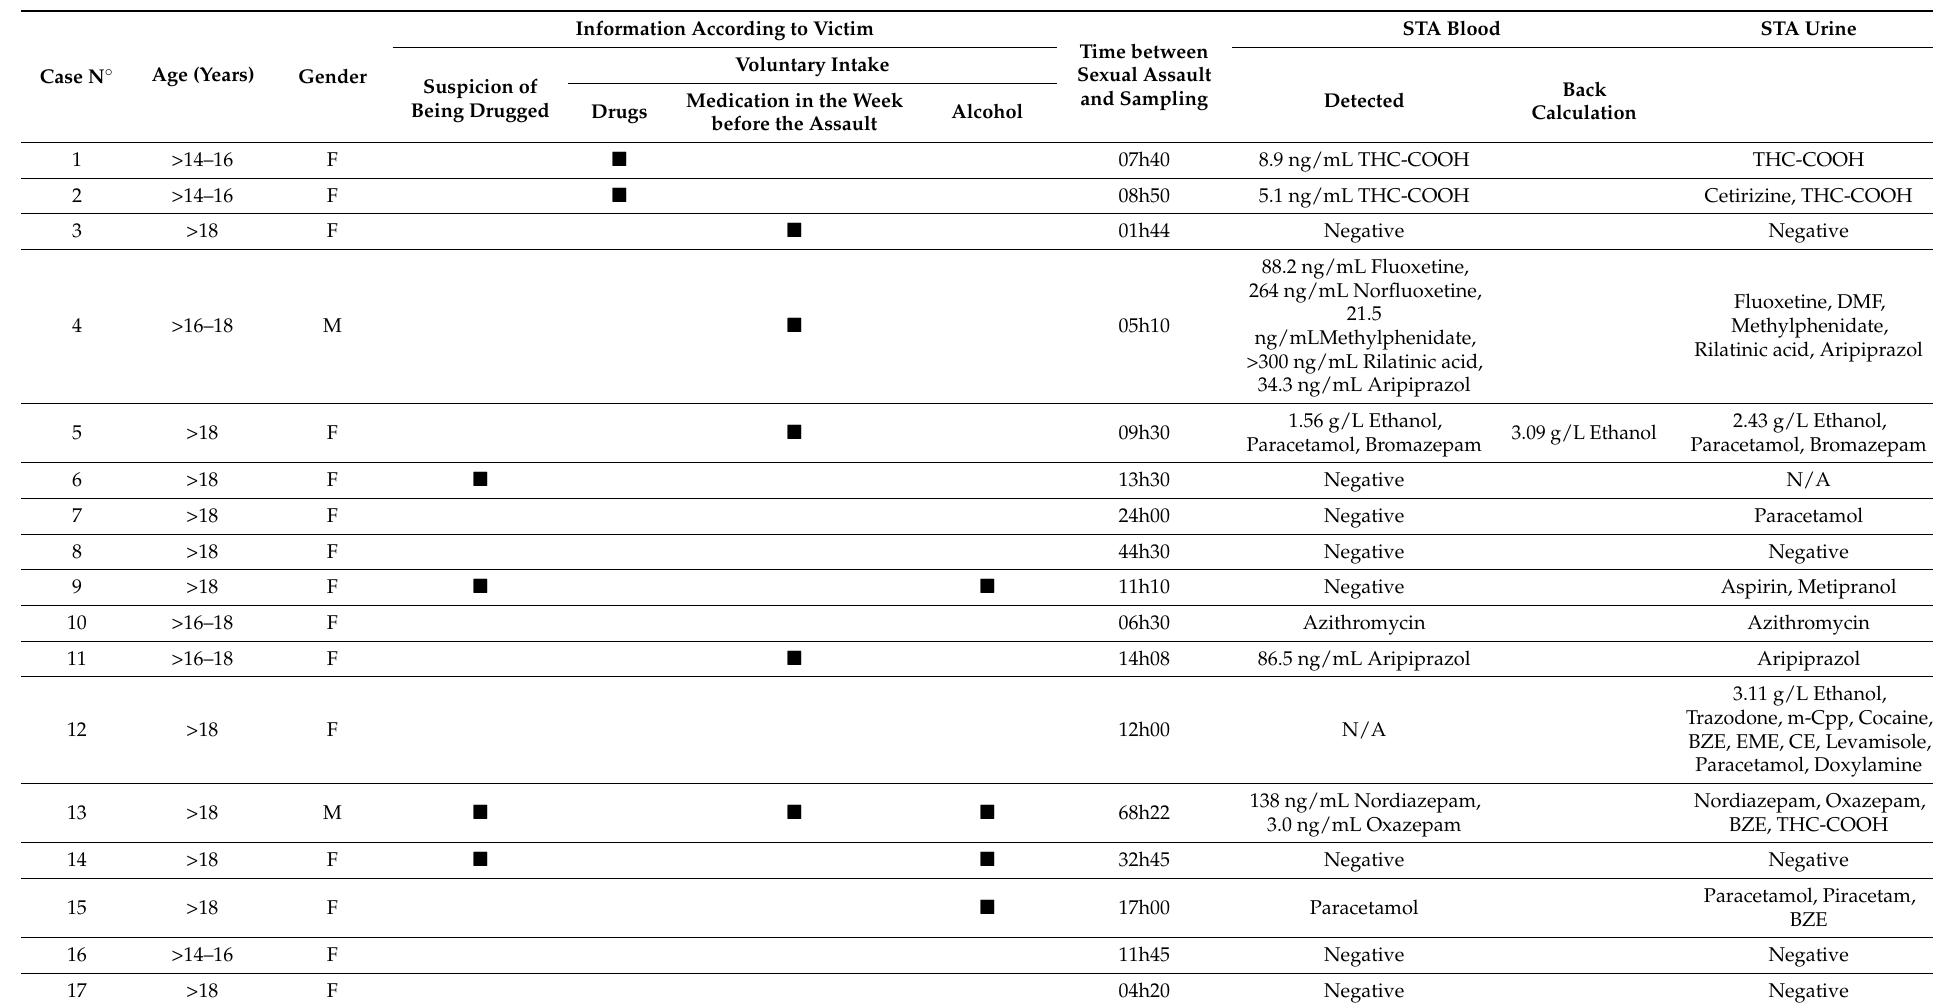
Table 1. Background characteristics and case